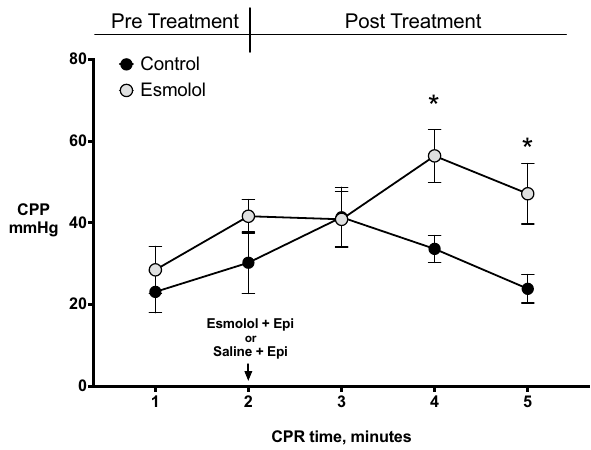
Figure 2. Coronary prefusion pressure (CPP) during cardiopulmonary resuscitation (CPR). Data are expressed as mean ± SEM. Repeated-measures two-way ANOVA was used to assess the treatment effect over time. * p < 0.05 vs.